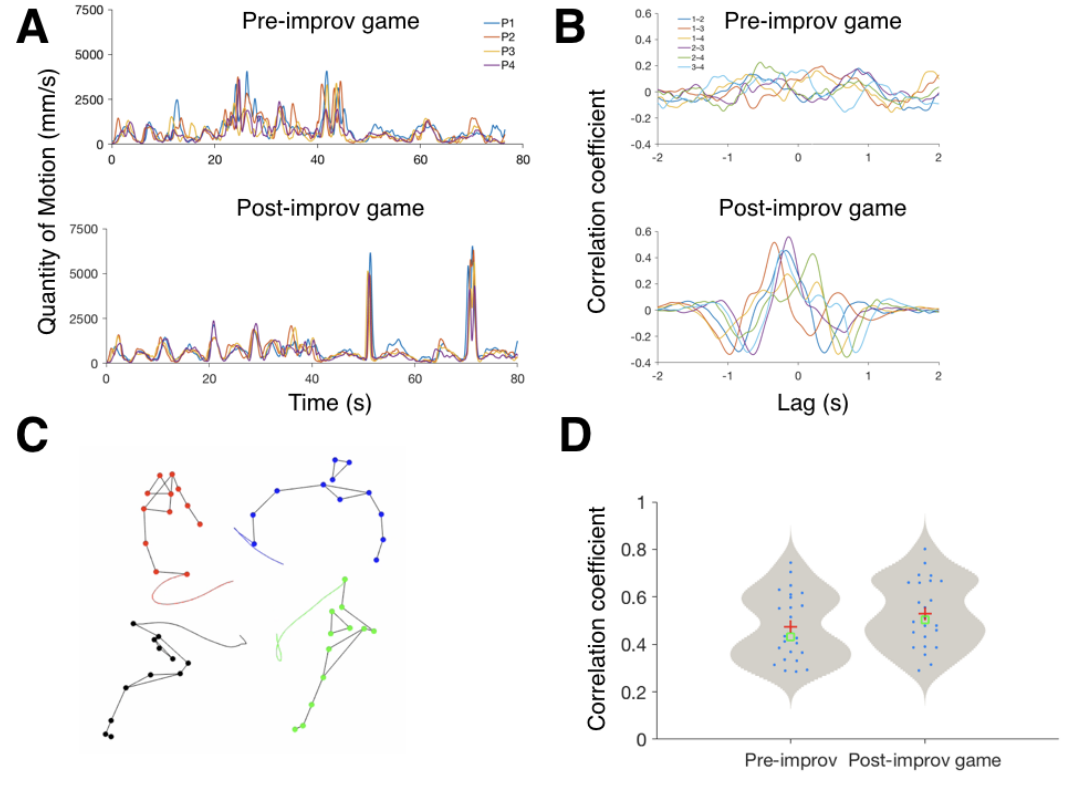
Figure 1. ( A ) Quantity of Motion in pre- (top) and post-improvisation mirror games in pilot 1; ( B ) Cross-correlation functions in pilot 1, indicating that group-level coordination was absent in pre-, but present in post-improvisation game; ( C ) Participants were standing in a circle, one arm and index finger extended. Frame from pilot 1, the movement trace shows finger trajectories for 1 s; ( D ) Distribution of maximum pairwise correlation coefficients in pilot 2. Red crosses are means, green dots medians, and blue dots represent the data points (pairwise